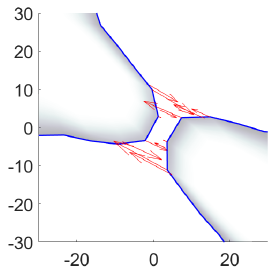
Fig. 7. Experiment 2 (Cell-cell adhesion). With a close- up in the adhesion zone, we visualize the cadherin adhesion forces. They are exerted at the plus ends of the filaments and are opposite to each other. In the middle region, the adhesion forces have been balanced by the repulsive collision